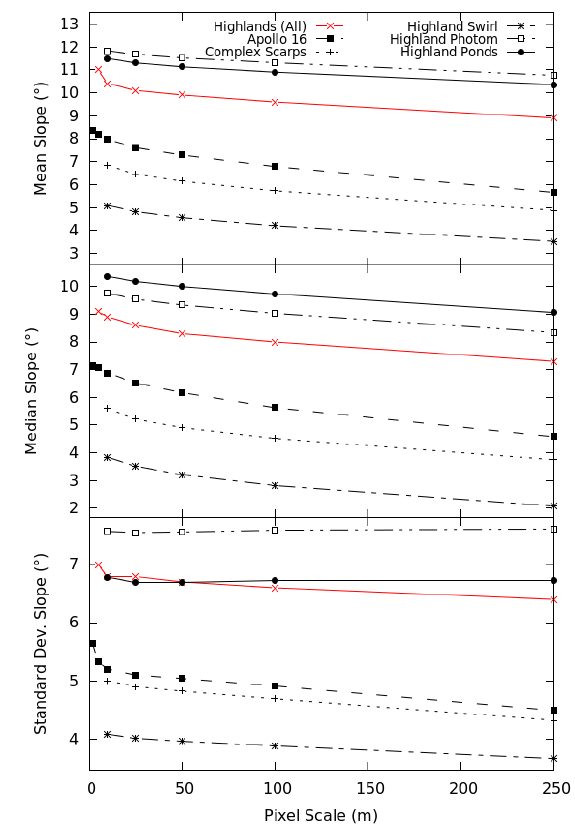
Figure 4. Mean, median, and standard deviation of slopes for DTMs of typical highland units compared to all highland DTMs. Curve marked “All” represents NAC highland DTM population analysed in Henriksen et al. 2016.